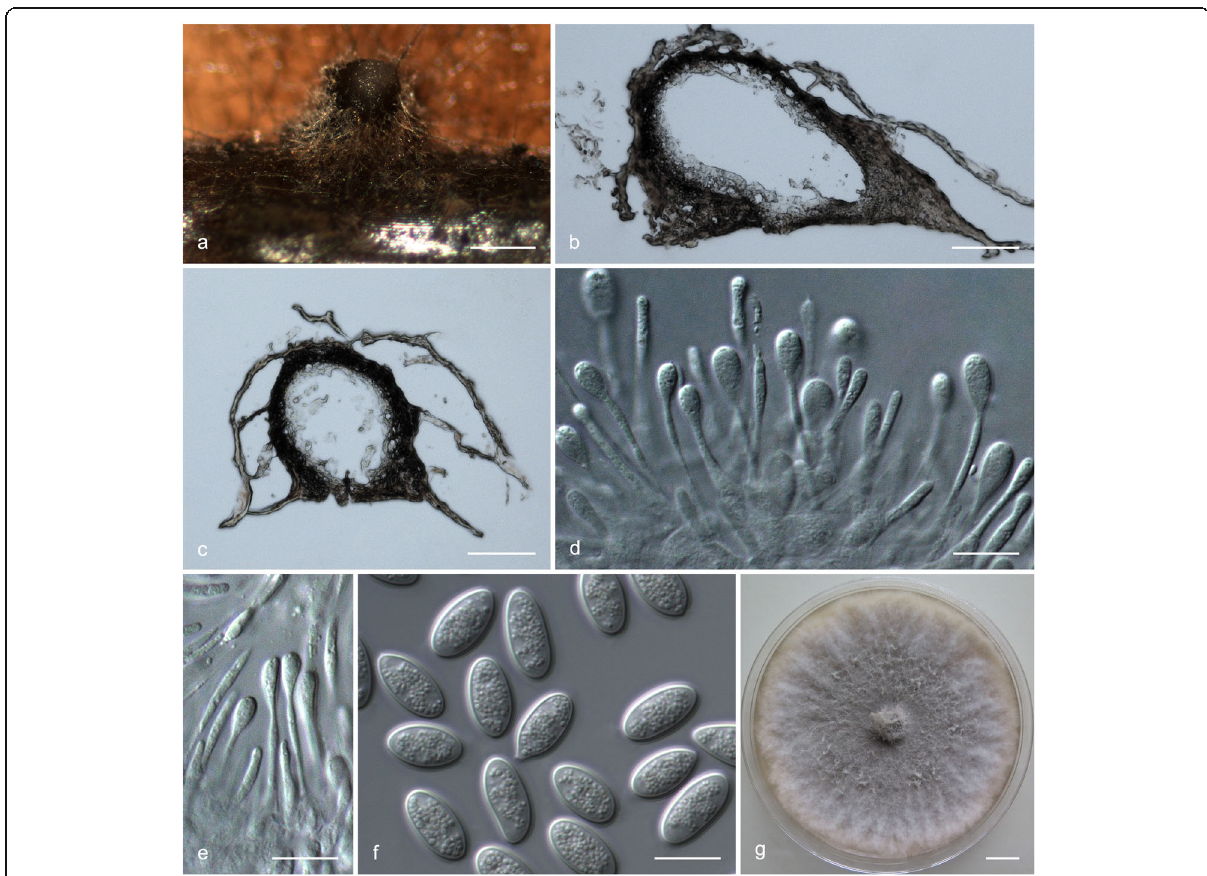
Fig. 9 Neofusicoccum parviconidium. a . Conidioma formed on pine needle culture; b , c . Longitudinal section through conidioma; d , e . Conidiogenous cells and developing conidia; f . Conidia; g . Living culture after 10 d on 2% MEA (front). Scale bars: a=500 μ m; b, c=100 μ m; d – f=10 μ m;